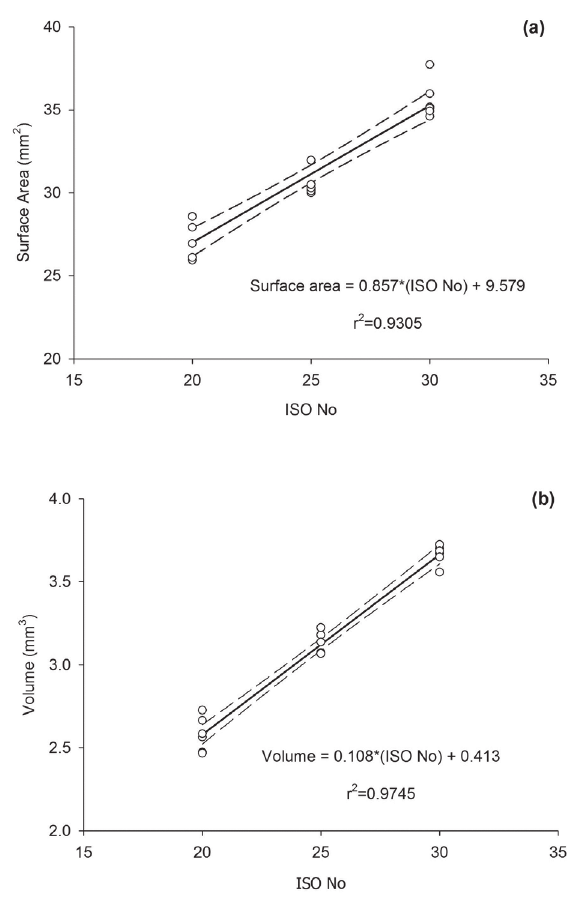
Figure 3- Raw data, fitted line with the 95% confidence intervals, mathematical equations and liner regression coefficients (r 2 ), for the surface area (a) and volume (b) of the FlexMaster Ni-Ti